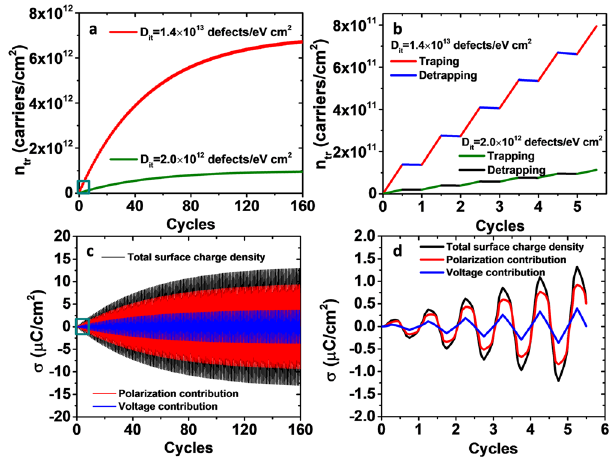
Fig. 7 Charge trapping as a function of fi eld cycling. a The carrier density per unit energy n tr as determined from the Shockley Read Hall (SRH) rate equation. Density of interface traps D it is the interface energy density of states. b Detail near the origin (marked by the square in ( a )), showing the trapping and de-trapping in each cycle. c The total charge σ trapped in all interface energy states which are made available by polarization P and bias V for D = 1.4 × 10 13 eV − 1 cm − 2 . d Detail at the origin (marked by square in it ( c )) showing separately the contribution of polarization (red) and voltage (blue) to the total trapped charge.